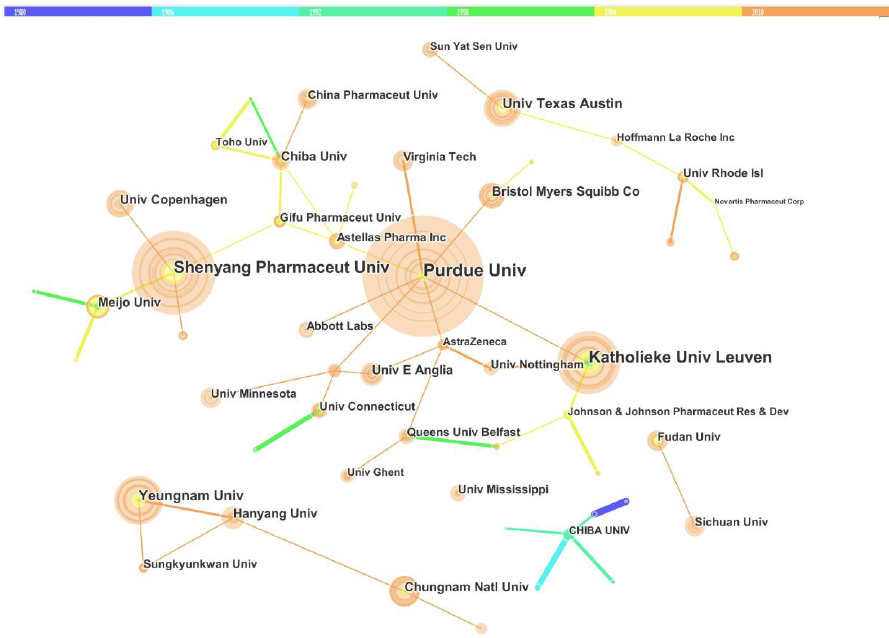
Figure 6. Mapping of Institution cooperation network. Different colors represent different time slices, deep blue: 1980 to1985, sky blue: 1986 to 1991, pink green: 1992 to 1997, green: 1998 to 2003, yellow: 2004 to 2009 and orange: 2010 to 2015 from 1980 to 2015. The diameter of each circle represents the publication number of the institution. The thickness of the connect line represents the intensity of institution cooperation. Molecules 2018 , 23 , x FOR PEER REVIEW